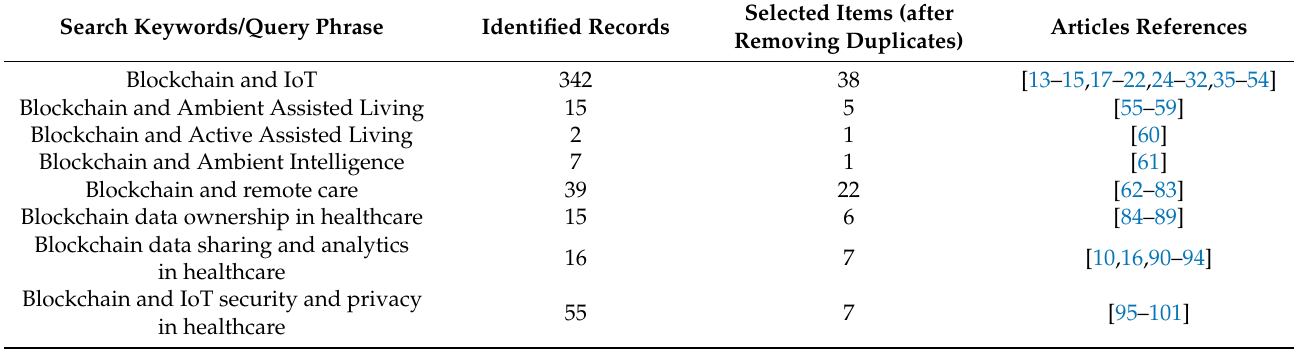
Table 2. Results overview.